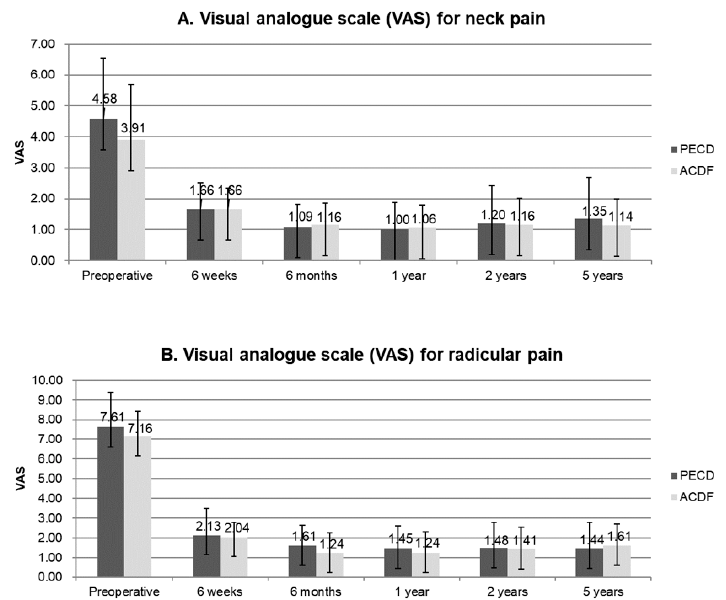
Figure 2. Visual analogue scale (VAS) measured preoperatively and at six weeks, six months, one year, two years, and five years postoperatively. A. VAS for neck pain. B. VAS for radicular pain. There were no significant di ff erences between the groups. PECD, percutaneous endoscopic cervical discectomy; ACDF, anterior cervical discectomy and